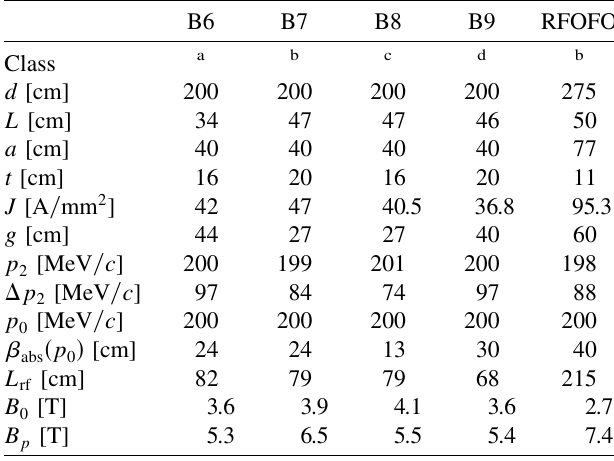
TABLE V. Summary of the two-cell characteristic solutions for the second momentum